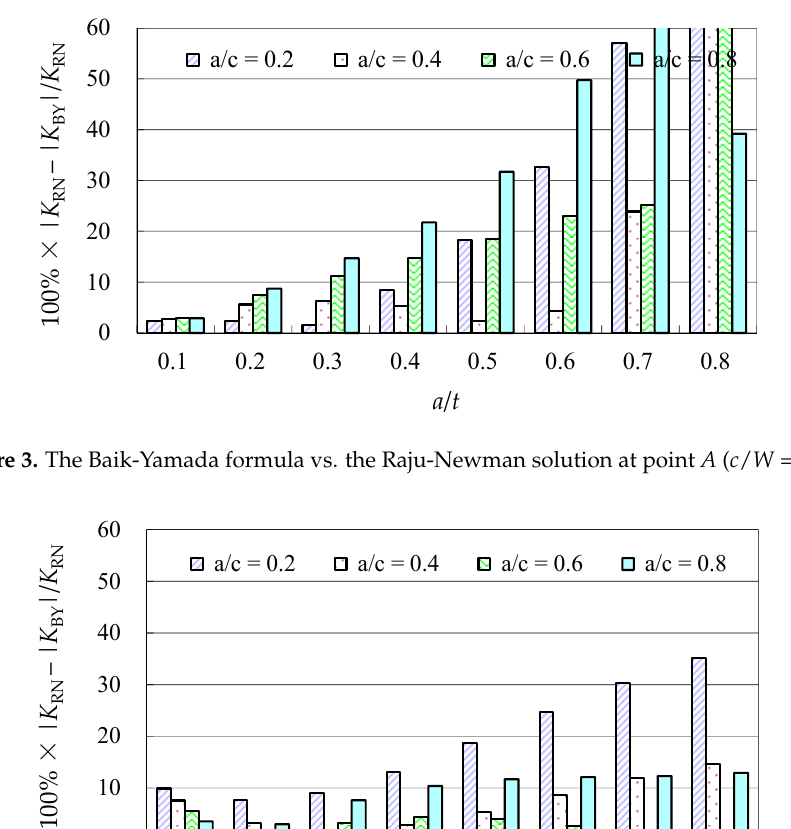
Table 1. The Baik-Yamada formula vs. the photo-elastic experimental data.